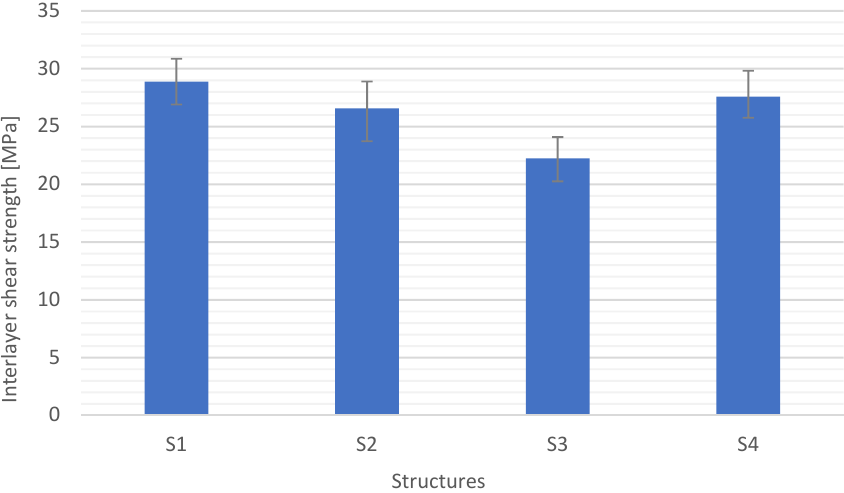
Figure 16. Interlayer shear strength for different composite structures.